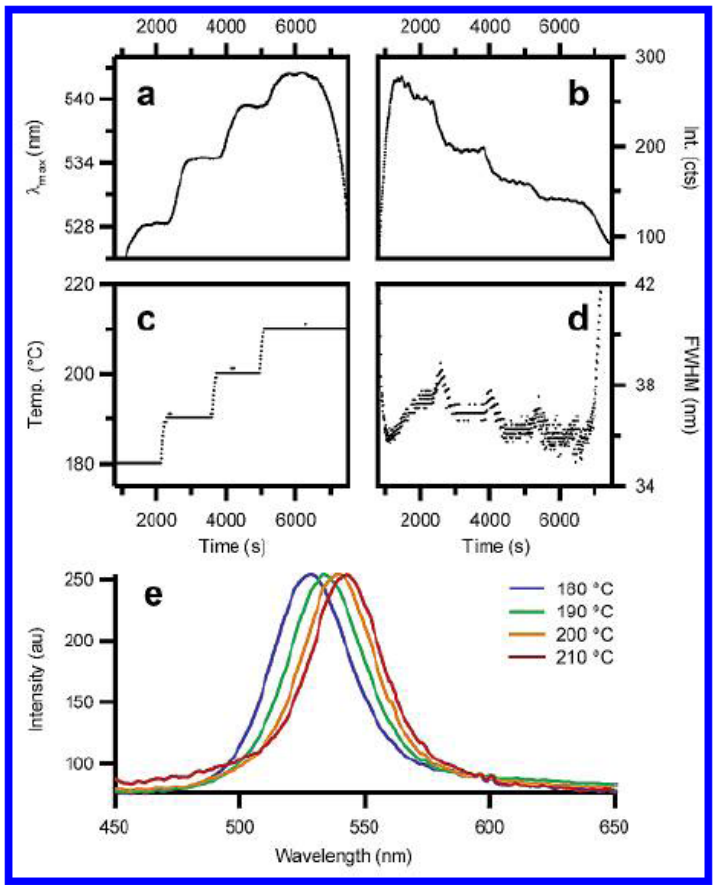
Figure 20. Size control of CdSe nanocrystal synthesis via flow rate and concentration (Reproduced with permission from ref.